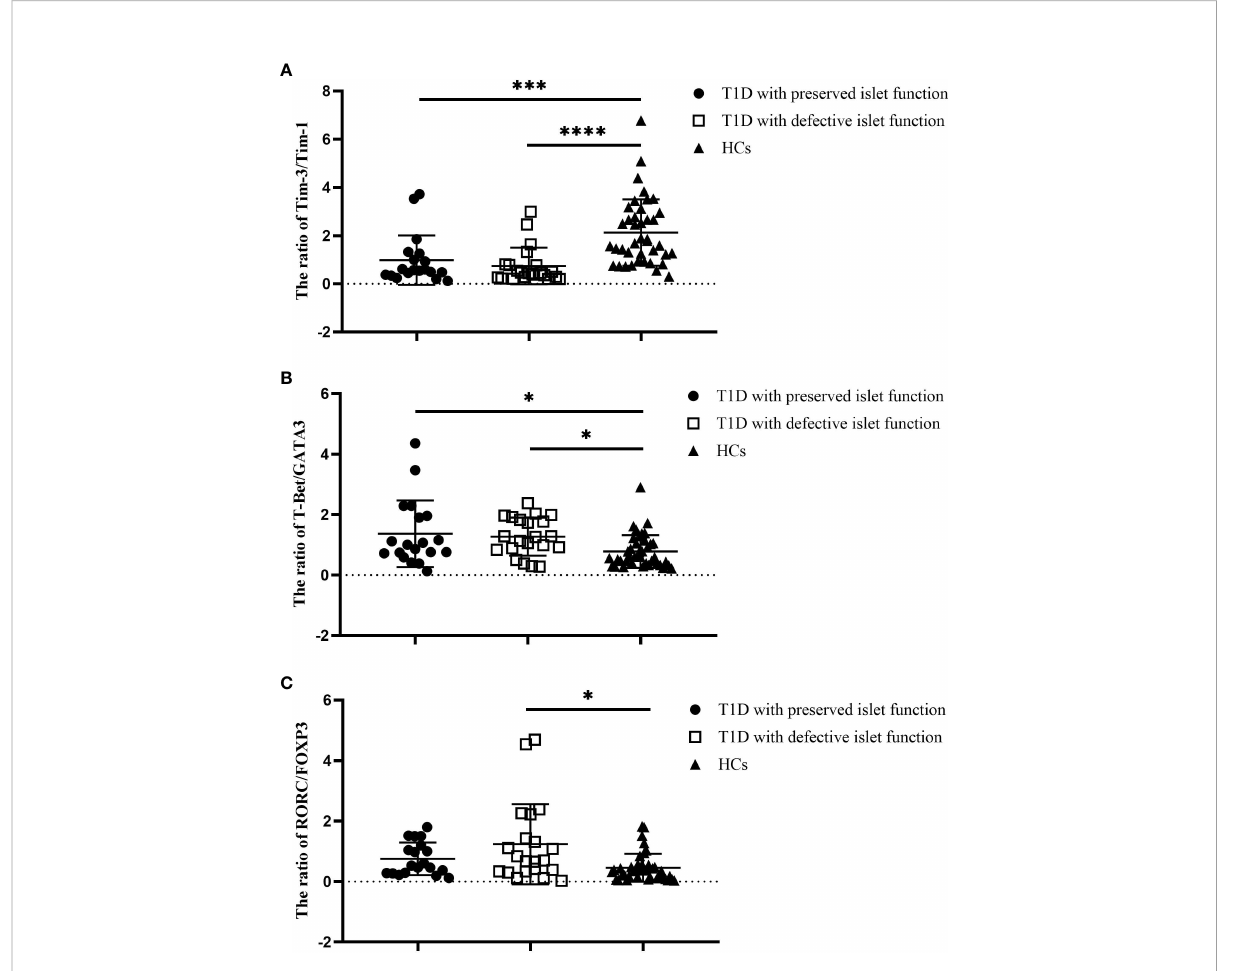
FIGURE 3 The ratios of Tim molecules and T-cell subset-speci fi c transcription factor expression in the T1D subgroups (n=40) and HCs (n=40). (A) The ratio of Tim-3 to Tim-1 in different T1D subgroups and the HC group. (B) The ratio of T-Bet to GATA3 in different T1D patient subgroups and the HC group. (C) The ratio of RORC to POXP3 in different T1D subgroups and the HC group. Error bars represent the standard deviation of the mean. * P <0.05; *** P <0.001; **** P